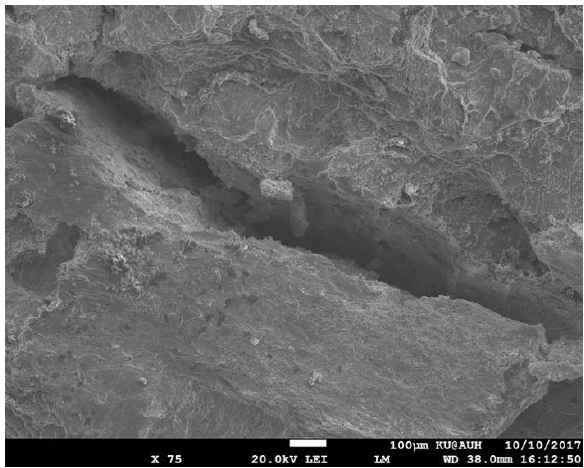
Figure 15. A large HIC crack at the SOHIC fracture region.